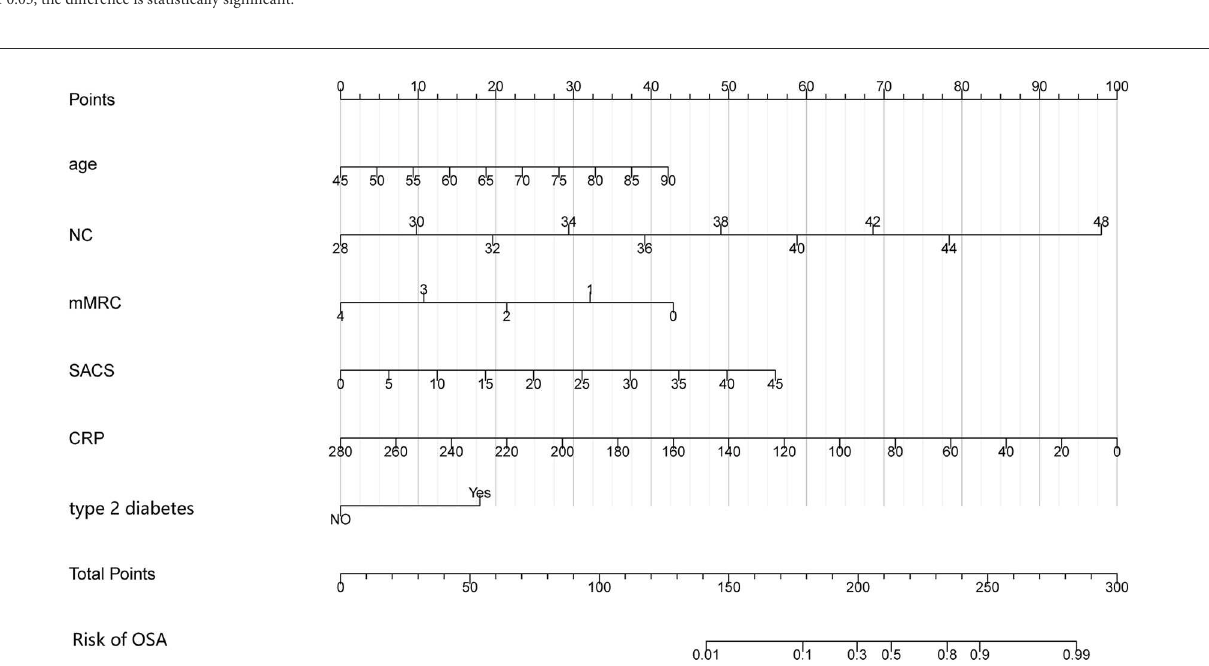
FIGURE1 Nomogram for predicting the risk of OSA in patients with COPD. The nomogram included six risk factors: age, NC, type 2 diabetes, mMRC questionnaire, SACS questionnaire, and CRP. The patient’s status for each predictor is plotted on a horizontal scale, and vertical lines are drawn to obtain the corresponding points. After all points have been summed, the total score on the total point line is plotted and a vertical line is drawn down to the accompanying line labeled Risk of OSA. The point where this line crosses the accompanying line indicates the predicted probability of diagnosis. COPD, chronic obstructive pulmonary disease; OSA, obstructive sleep apnea syndrome; NC, neck circumference; mMRC, modified Medical Research Council; SACS, Sleep Apnea Clinical Score; CRP, C-reactive